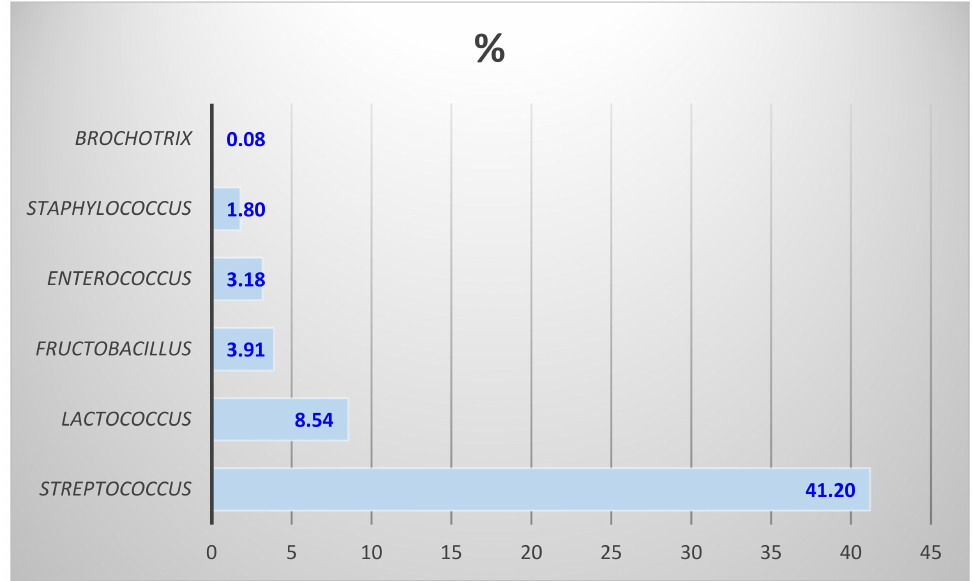
Figure 3. Gram-positive genera detected in Slovak ewe’s lump cheeses (in